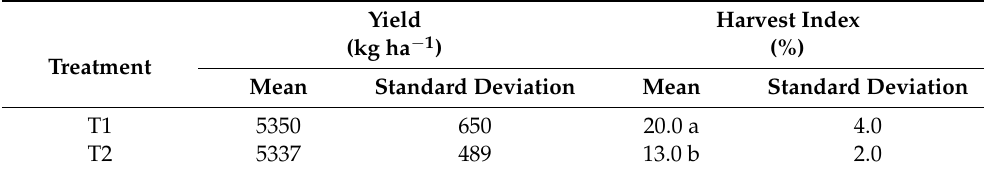
Table 2. Yield and harvest index (%) for the irrigation treatments (T1 = Control; T2 = Drought).